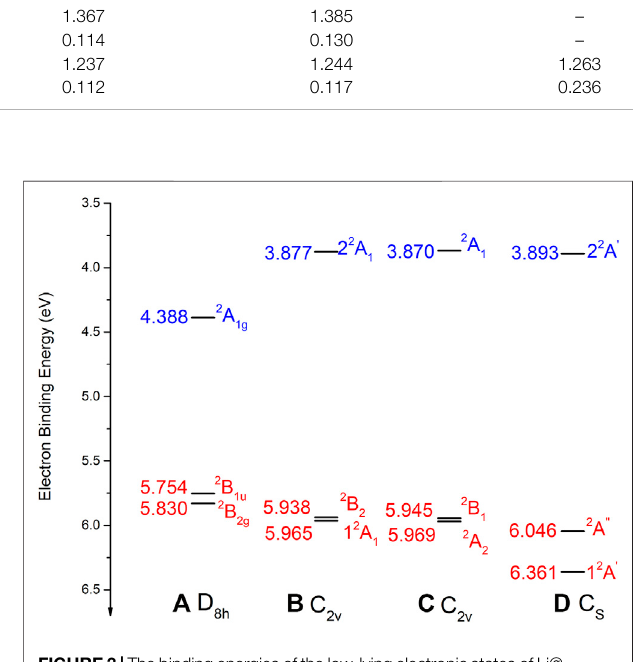
FIGURE3| Thebindingenergiesofthelow-lyingelectronicstatesofLi@ C 16 obtained at the EA-EOM-CCSD level of theory at the optimized geometriesoftherespectivestructures (A – D) .Forthestructuressee Figure1 The data of Li@C 16 in D 8 h are taken from (Yang et al., 2019b). For more details see text. Charge-separated states are shown in red and non-charge- separated (encircled-electron) states are colored in